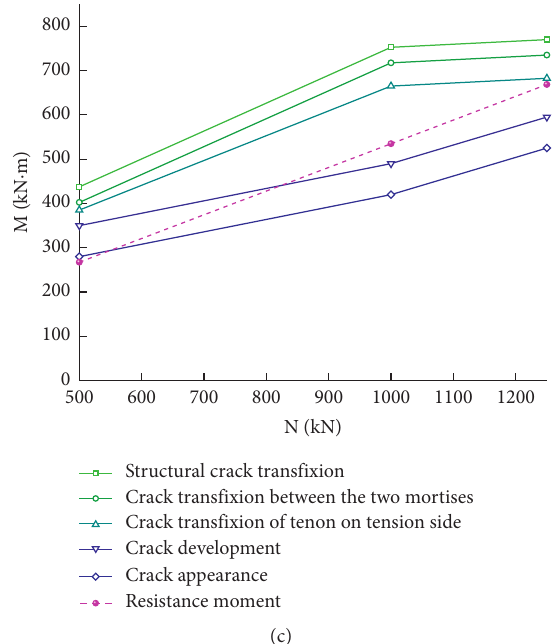
Figure 15: Key bending moments of different double mortise-tenon joints under various loads: (a) without auxiliary pretightening device; (b) auxiliary pretightening device on tension side; (c) auxiliary pretightening device on compression